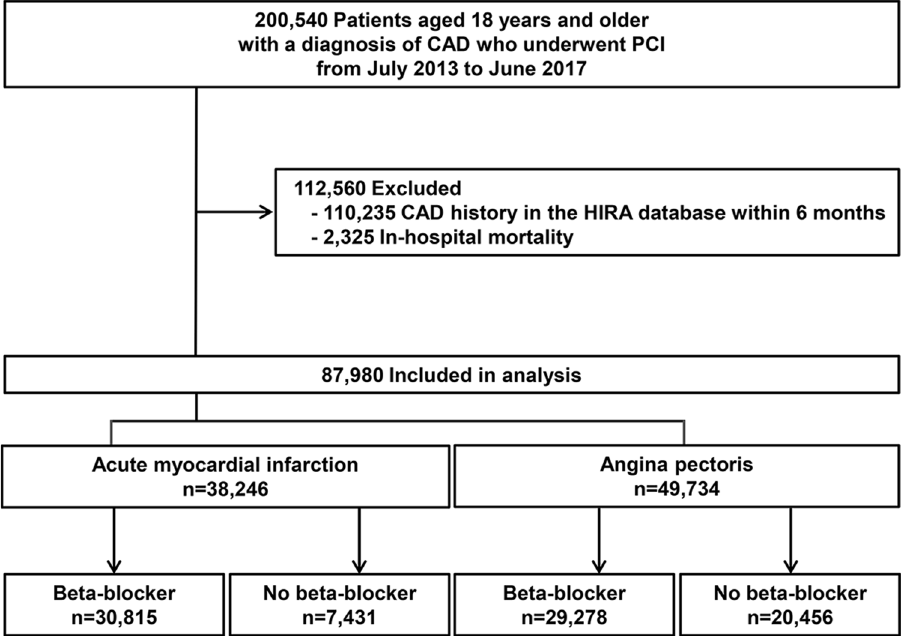
Figure 1. Overview of the study population. CAD, coronary artery disease; HIRA, Health Insurance Review and Assessment; PCI, percutaneous coronary